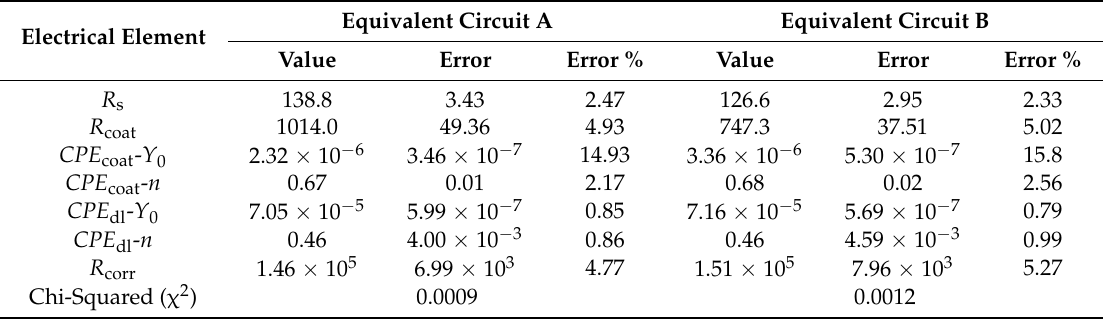
Table 5. Values obtained for the elements of the proposed equivalent circuits applying CNLS fits of the ZView software on experimental impedance plots of samples S6 (600 ◦ C/2 h) and S8 (800 ◦ C/2 h), respectively. Immersion time in SBF: 5